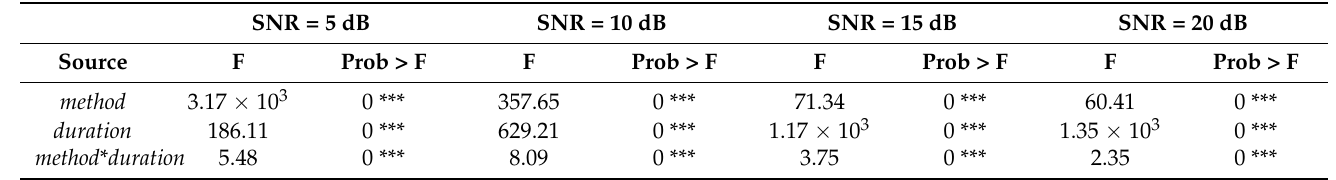
Table 2. Two-way ANOVA for the analysis of interaction effects between the method and the duration factors. Each ANOVA test was performed considering one level of SNR at time. The significance level is set at: * p < 0.05, ** p < 0.01 and *** p < 0.001. Mean square, F-statistic, and p -value are provided. All the values less than 2 × 10 − 16 are indicated as 0, with the corresponding significance indicated by *** p <